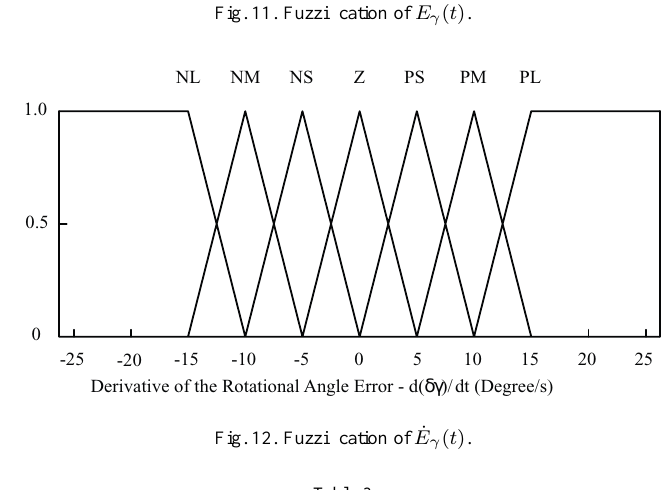
Fig. 12. Fuzzification of ˙ E γ ( t )